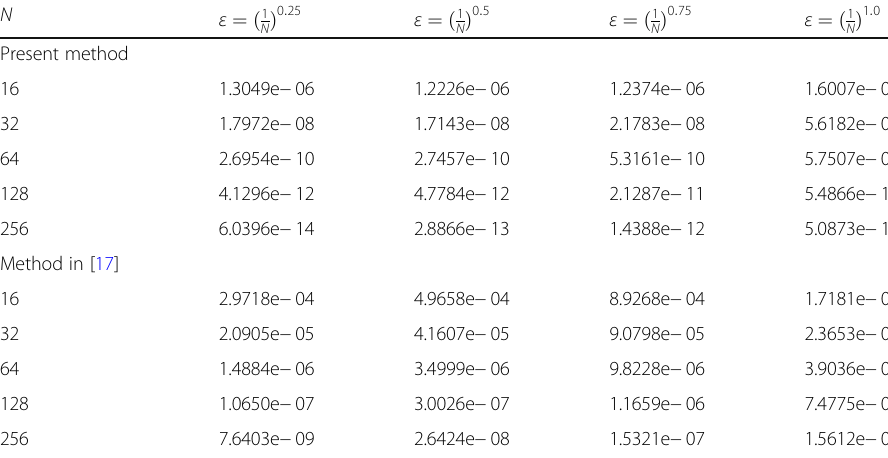
Table 4 Comparison of maximum absolute errors for Example 2 N